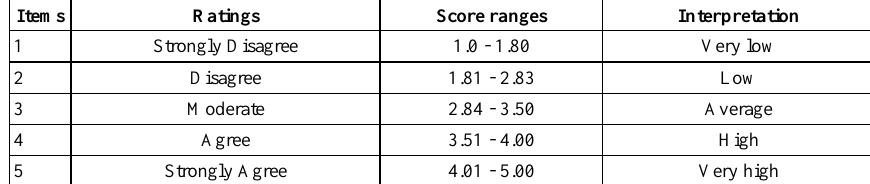
Table 4. Five-point Likert scale interpretation (TPACK areas of